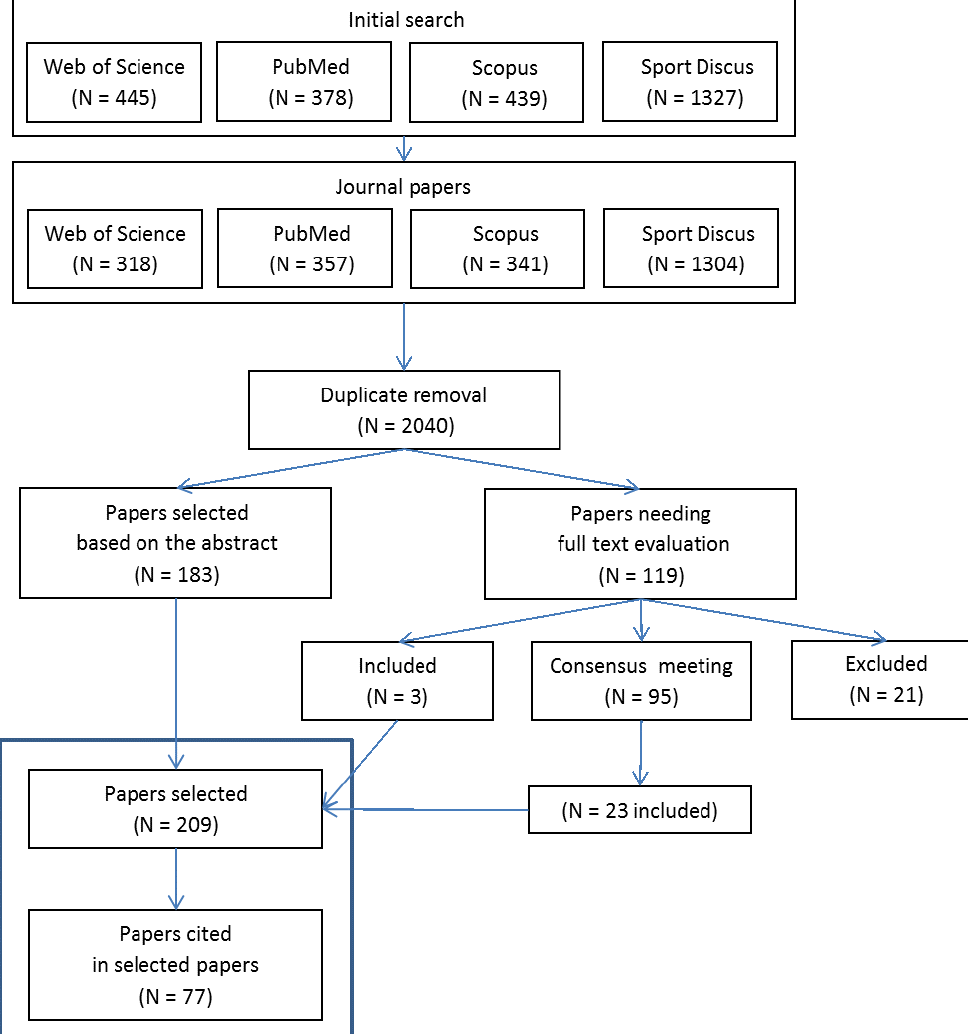
Figure 1. Search strategy flow chart. After the removal of duplicates, 2040 papers were screened for inclusion: 183 were selected based on title and abstract, 119 full texts were further analysed. Three were included directly and 23 out of 95 were included after a consensus meeting. The references of the 209 papers obtained from the database search and those cited in the 23 reviews included in this paper were screened leading to the inclusion of further 77 papers for an overall total of 286 papers.